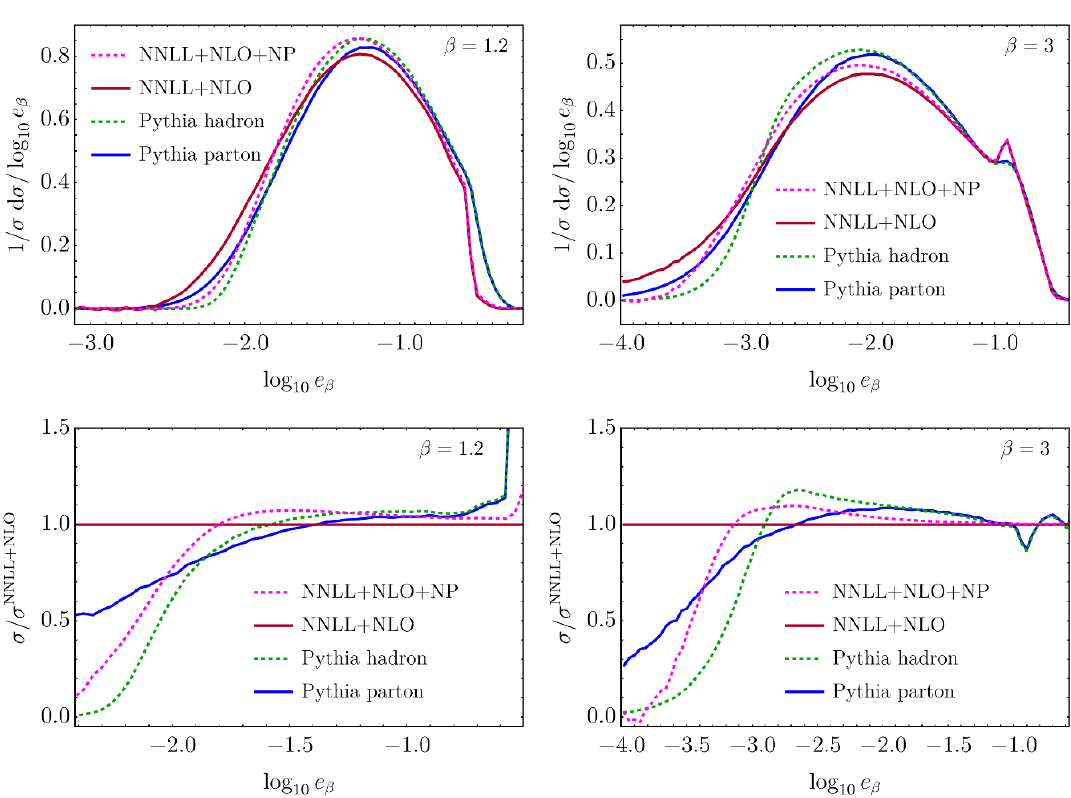
Figure 8 . NNLL+NLO without and with nonperturbative e(cid:11)ects, compared to Pythia at parton and hadron level, for (cid:12) = 1 : 2 (left) and (cid:12) = 3 (right). The bottom row shows the ratio with the NNLL+NLO cross section.